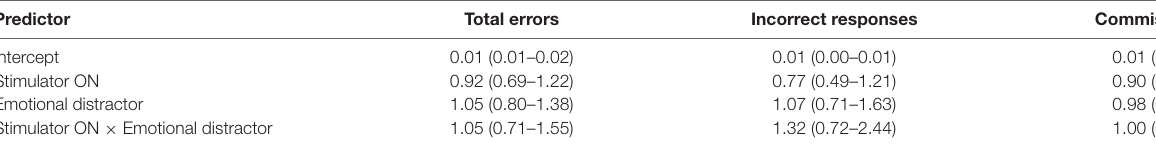
TABLE 3 | Odds ratios of error analysis.